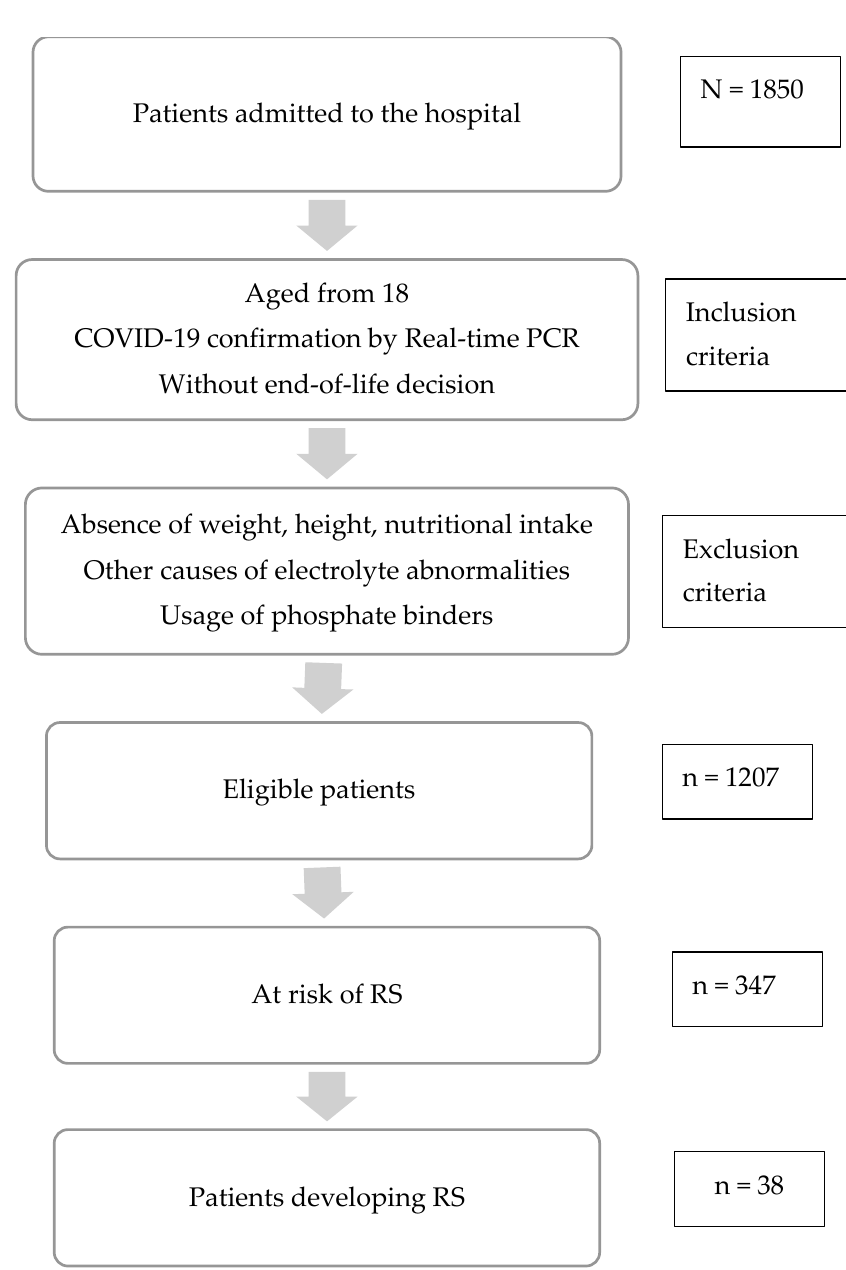
Figure 1. Selection of the study participants .